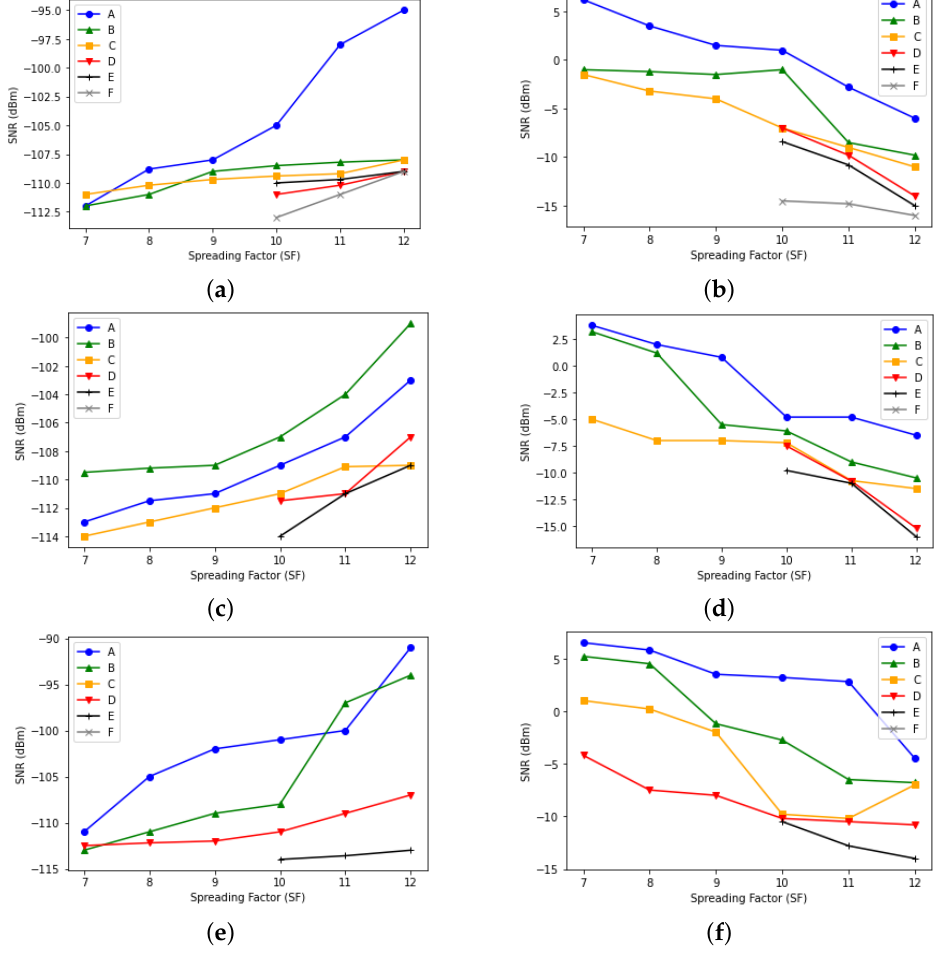
Figure 35. Average RSSI and SNR per point and SF LoRaMESH. ( a ) SNR left side. ( b ) SNR left side. ( c ) SNR front side. ( d ) SNR front side. ( e ) SNR right side. ( f ) SNR right